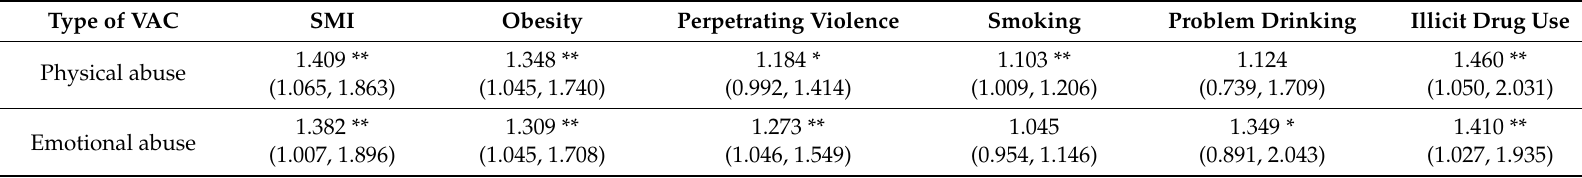
Table A3. Relative risks (RRs) for health outcomes associated with childhood violence based on the secondary analysis of the Cape Area Panel